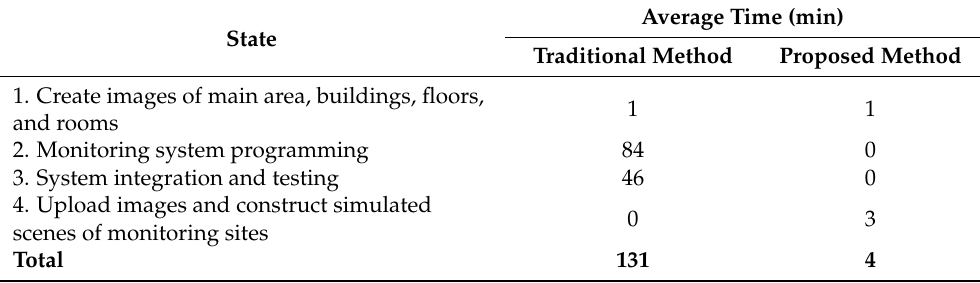
Table 4. Comparison of the time required to establish graphical monitoring interfaces in the proposed and traditional